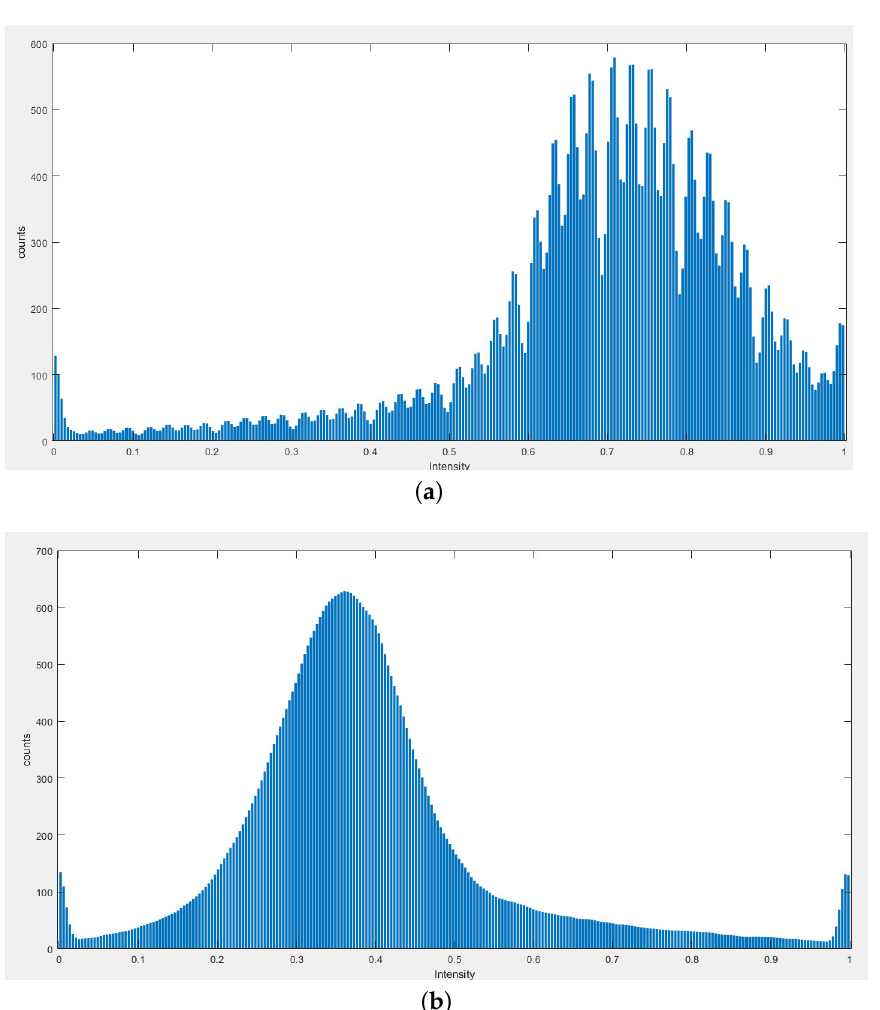
Figure 6. PCA Green channel Histogram and Morphological operation Green channel Histogram Comparison ( a ) Green channel histogram of morphological operation ( b ) Histogram of the PCA Green